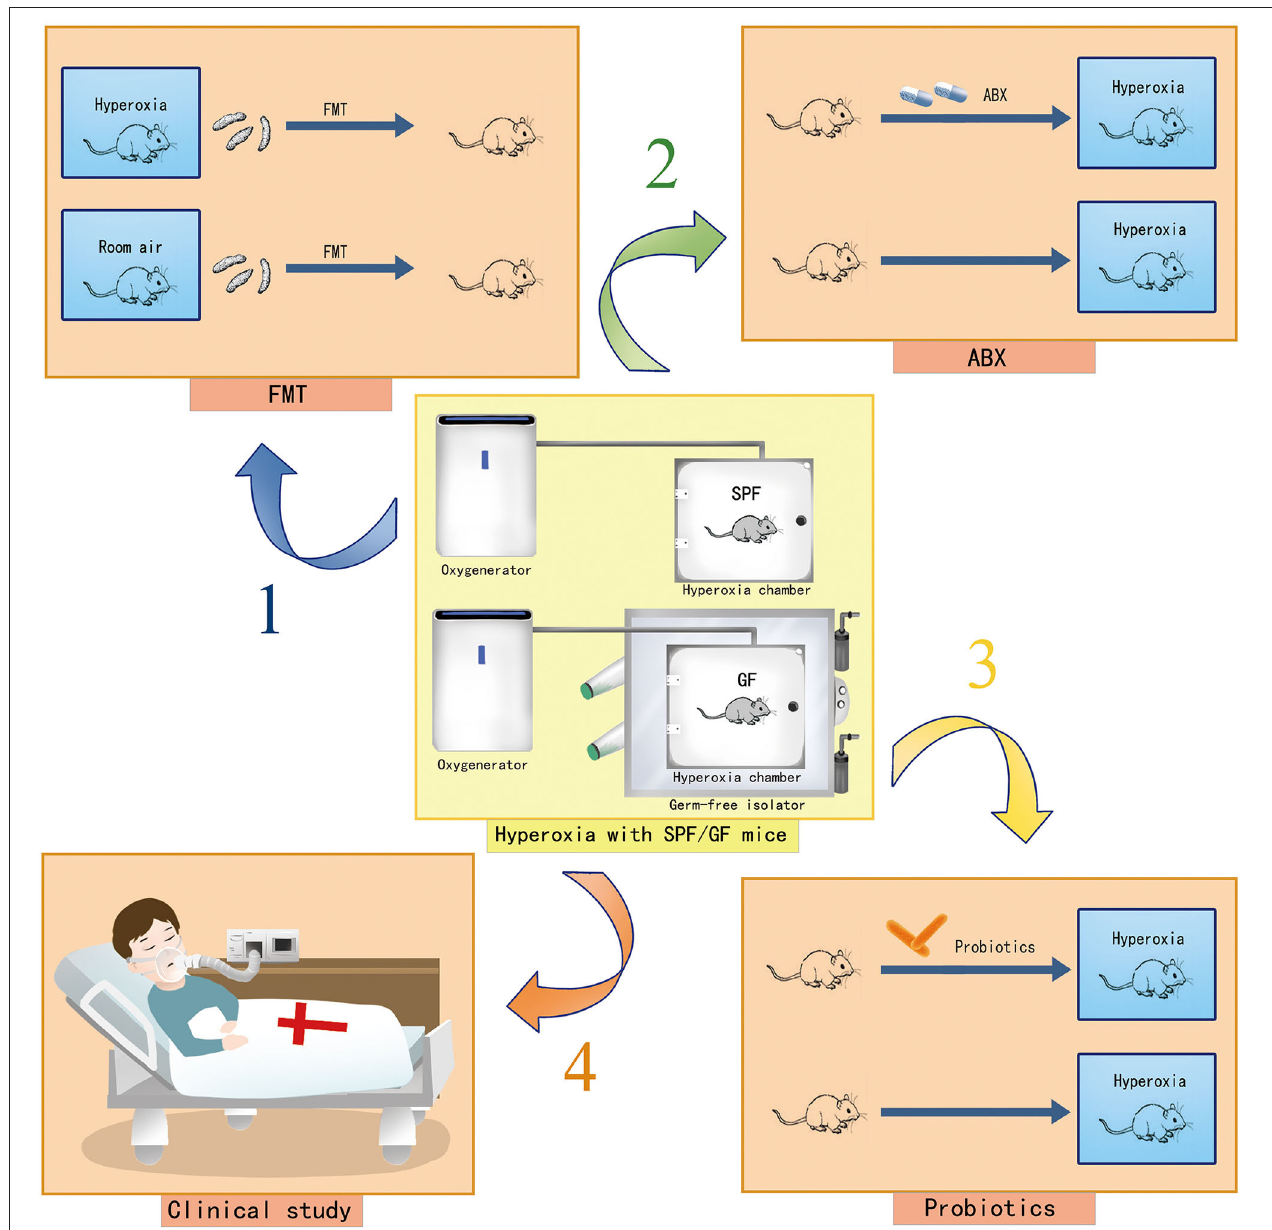
FIGURE 9 | Cartoons showing the study protocol to explore the role of gut dysbiosis in hyperoxia-induced gut injury. Hyperoxia modeling with GF mice in a GF isolator and hyperoxia modeling with SPF mice are presented. Arrow 1 indicates hyperoxia modeling with FMT to identify the targeted bacteria involved in an oxygen-induced gut injury. Arrow 2 indicates hyperoxia modeling with ABX mice to explore the impact of systemic antibiotic treatment on the severity of the oxygen-induced gut injury. Arrow 3 indicates hyperoxia modeling with probiotics to explore the protective effect of probiotics on the oxygen-induced gut injury. Arrow 4 indicates the translational research in clinical settings to assess the impact of conservative oxygen therapy vs. liberal oxygen therapy on gut microbiome and outcomes of patients in ICU. GF, germ-free; SPF, specific pathogen free; FMT, fecal microbiota transplantation; ABX, antibiotic treated; ICU, intensive care